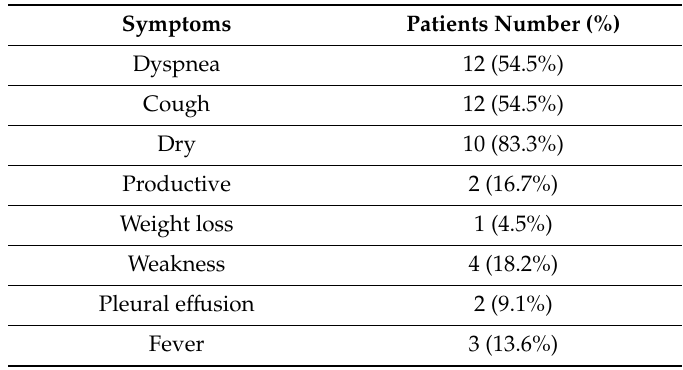
Table 3. Clinical and functional features. FVC: forced vital capacity, FEV1: Forced expiratory volume in 1 second, DLCO: di ff usion lung carbon